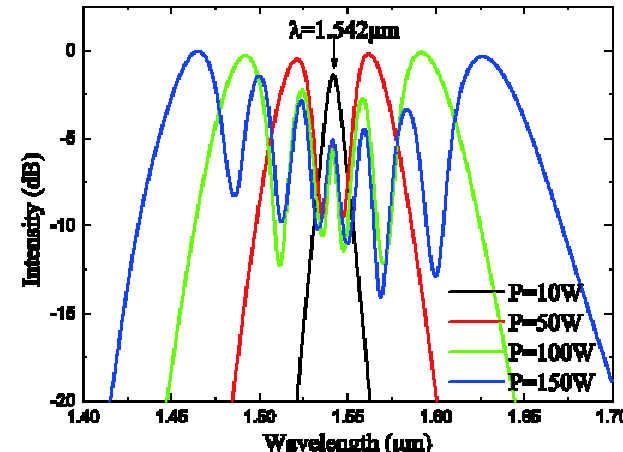
Figure 10. Spectrum spreading at the early stage of supercontinuum generation (SCG) at di ff erent peak powers.